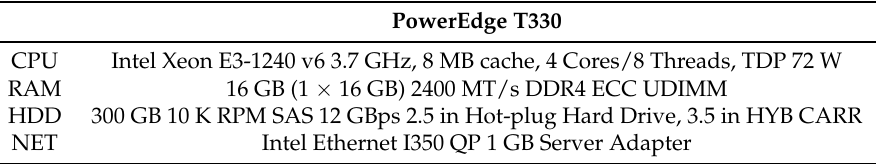
Table 2. Server H/W